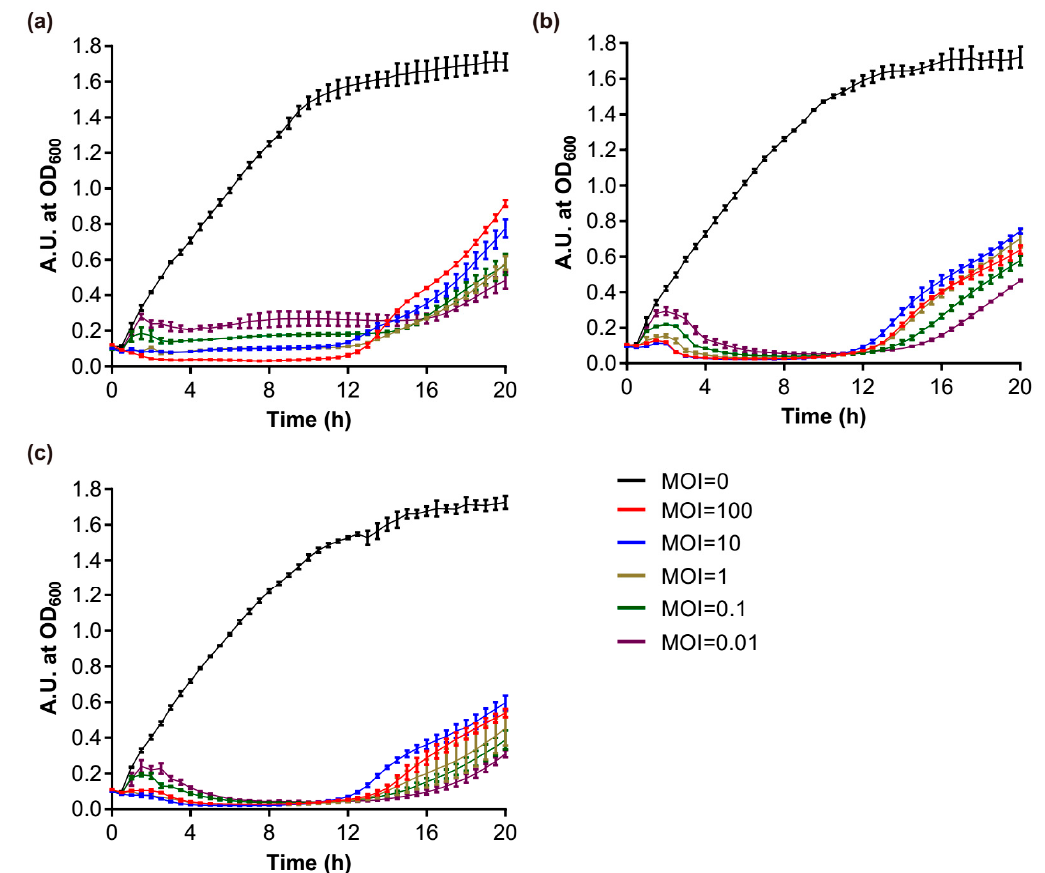
Figure 8. Growth curves of PAO1 strains infected with different phages. ( a ) vB_PaeM_SCUT-S1 of different MOIs; ( b ) vB_PaeM_SCUT-S2 of different MOIs; ( c ) vB_PaeM_SCUT-S1 and vB_PaeM_SCUT-S2 were combined in a 1:1 ratio to the indicated final MOIs.